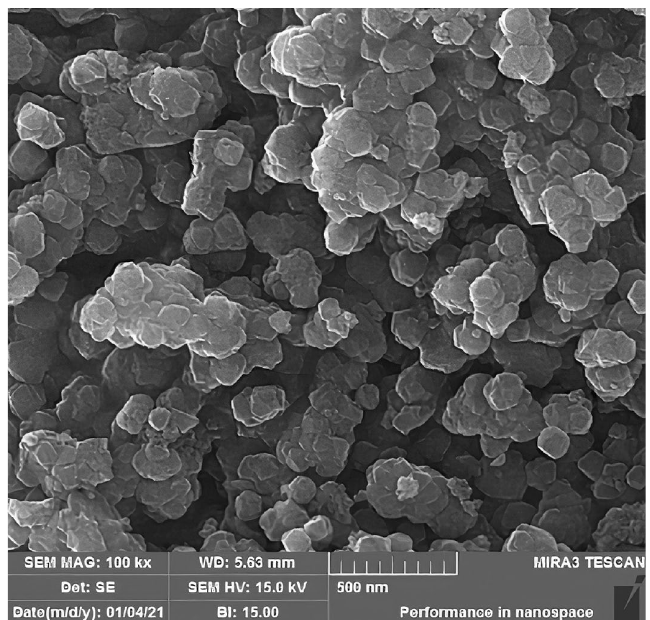
Figure 6. SEM analysis of Fe 3 O 4 @UiO@DAS.